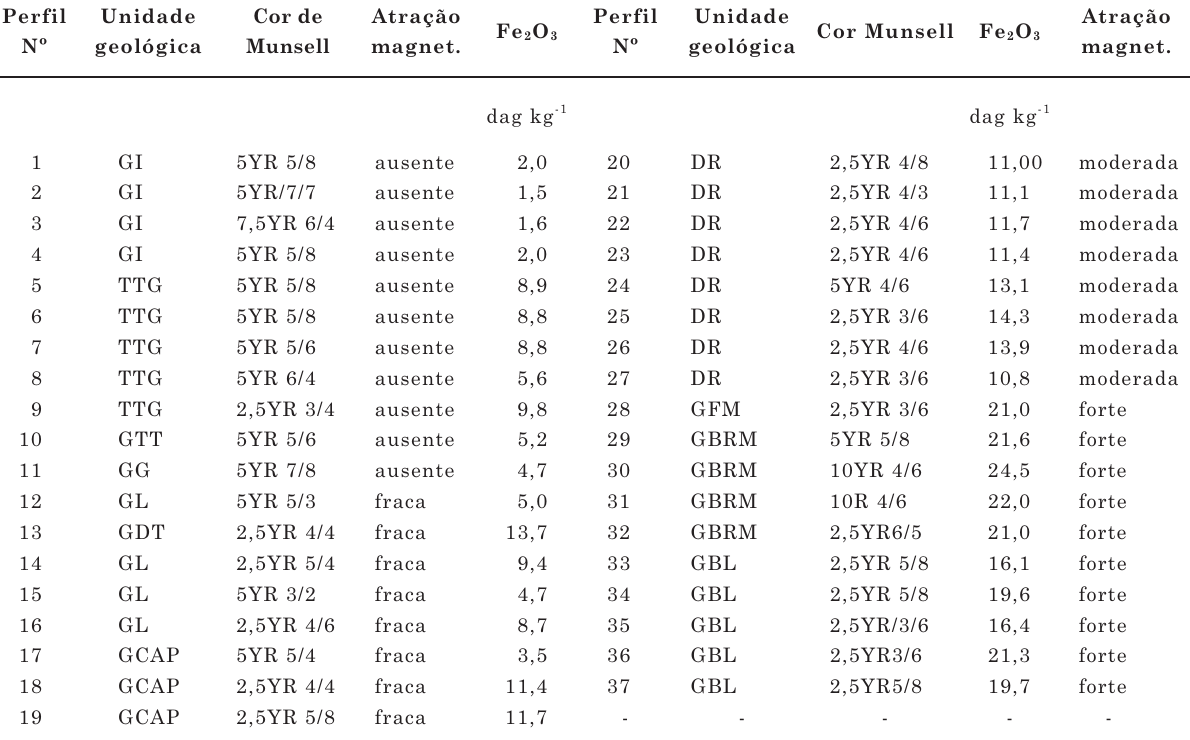
TTG: Gnaisse Pau da Bandeira; GL: Gnaisses Granodioríticos de Lavras; GG: Gnaisses Graníticos; GCAP: Granulitos Cálcio- Alcalino-Potássicos – Charnockitos; GTT: Granulitos Tonalítico-Trondhjemíticos – Enderbitos; GBRM : Anfibolitos e Rochas Ultrabásicas do Greenstone-belt Rio das Mortes; GBL: Anfibolitos e Rochas Ultrabásicas do Greenstone-belt de Lavras; DR: Diorito do Rosário; GFM: Gabro da Fazenda Martins; GI: Granito de Itutinga; GDT: Granodioritos